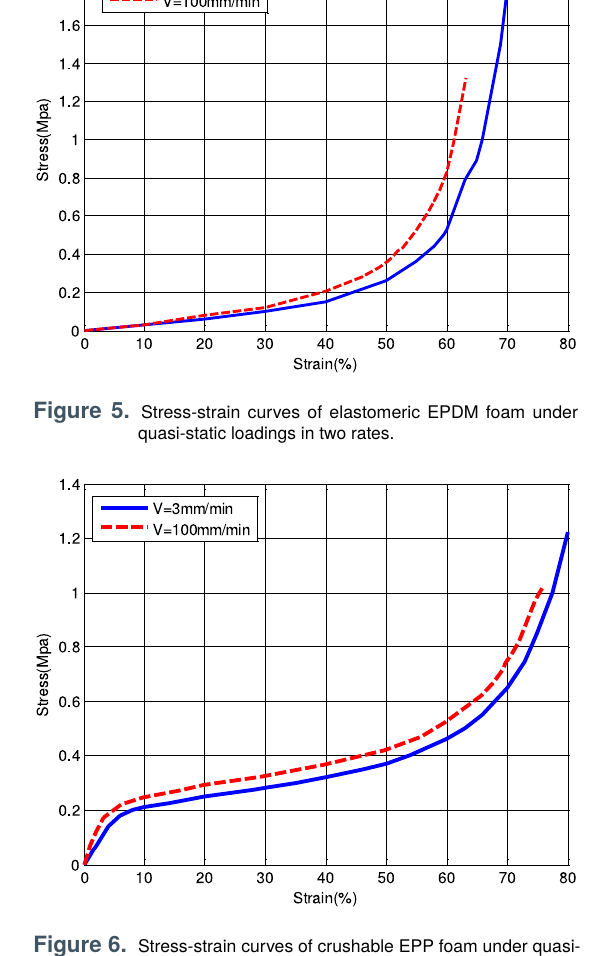
Figure 6. Stress-strain curves of crushable EPP foam under quasi- static loadings in two rates.